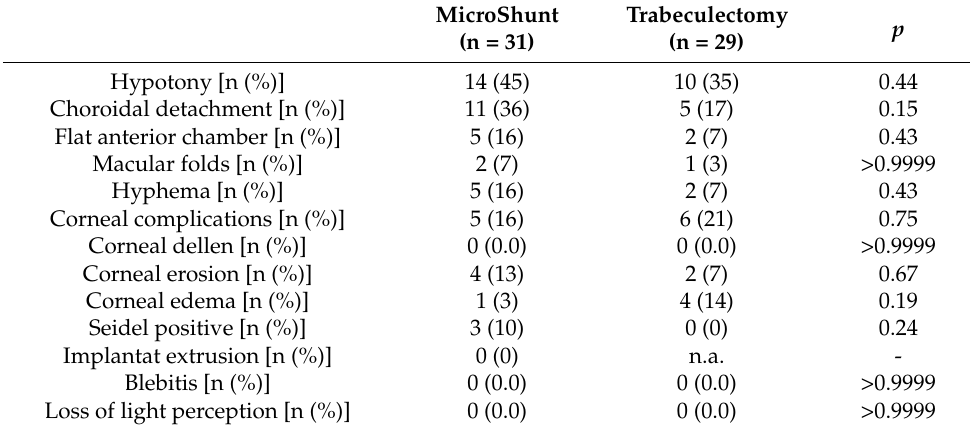
Table 3. Postoperative